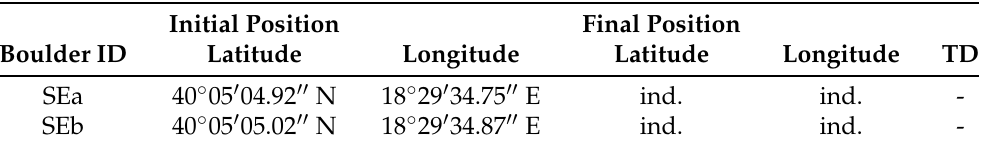
Table A15. Initial and final geographical coordinates of the displaced boulders at the Torre Sant’Emiliano coast; ind., indeterminable. TD = Transport Distance (m).